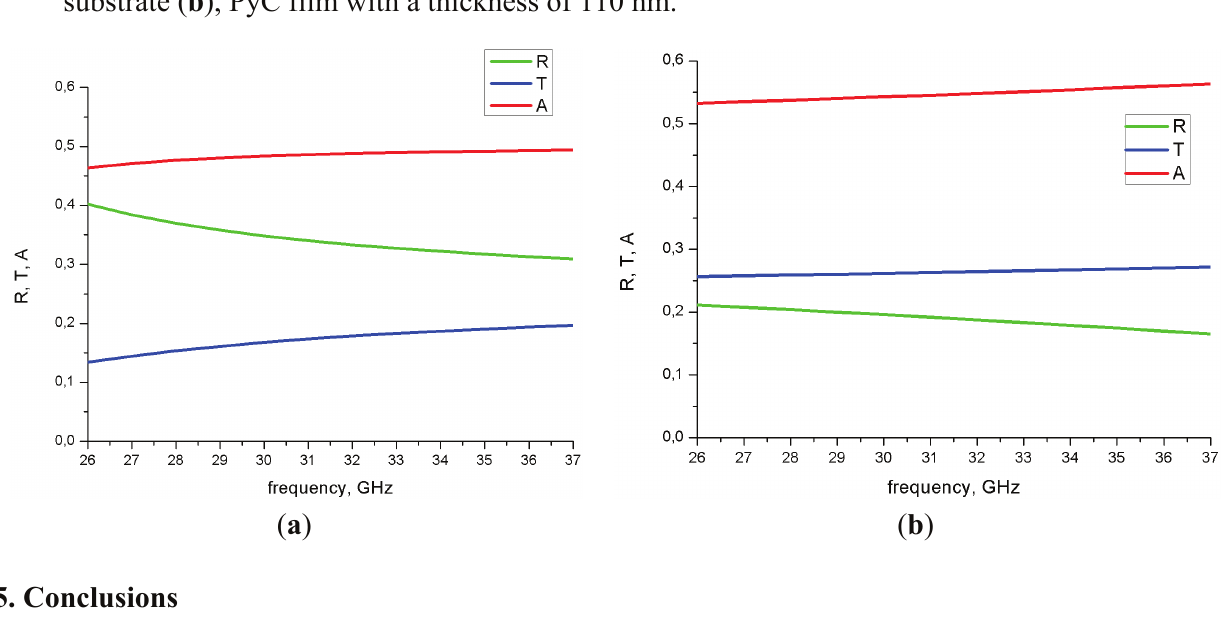
Figure 4. Frequency dependence of the reflectance, transmittance and absorbance calculated for free standing ( a ), and deposited on the back of the 0.5 mm thick quartz substrate ( b ), PyC film with a thickness of 110